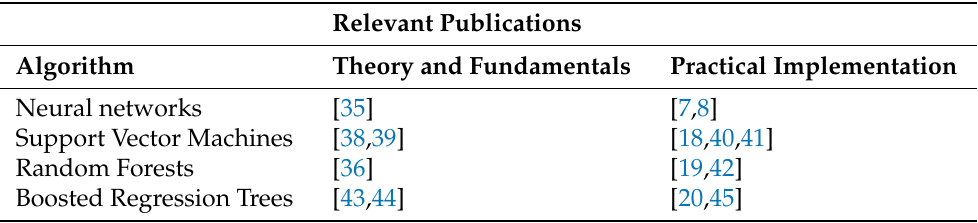
Table 1. Reference publications on the ML algorithms